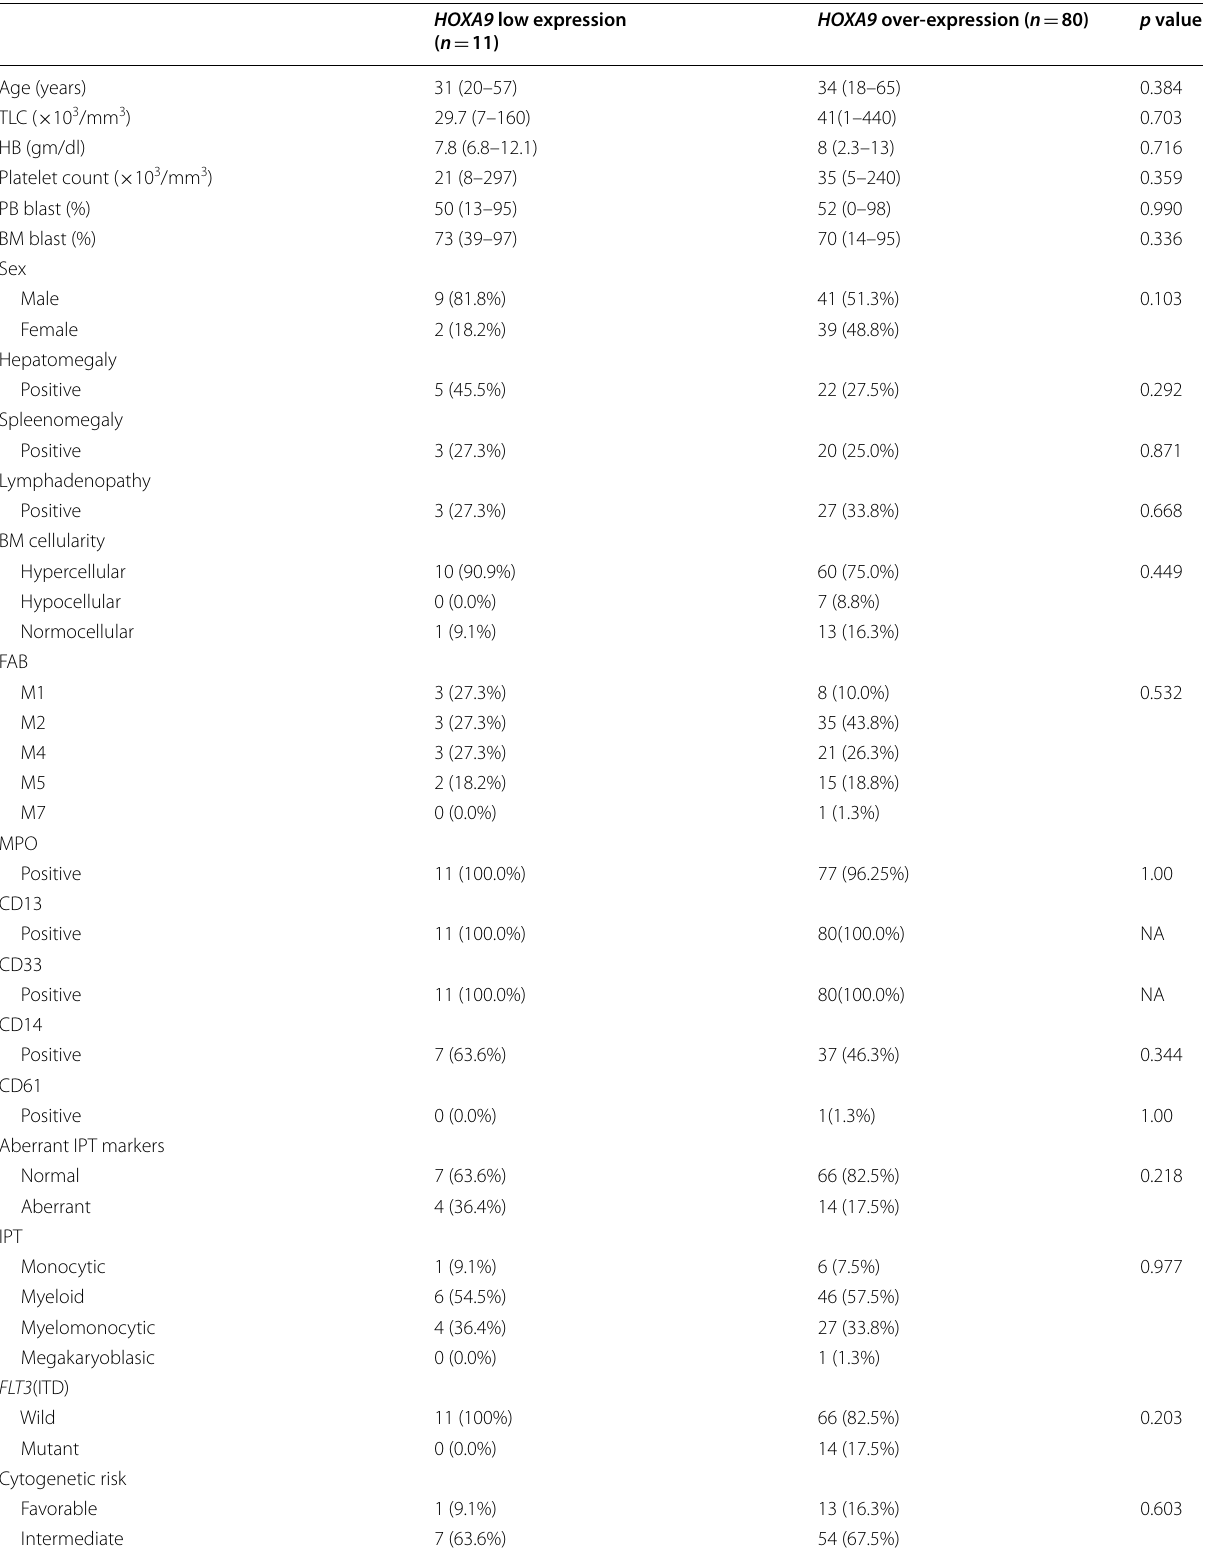
Table 3 Association between HOXA9 gene expression and patients’